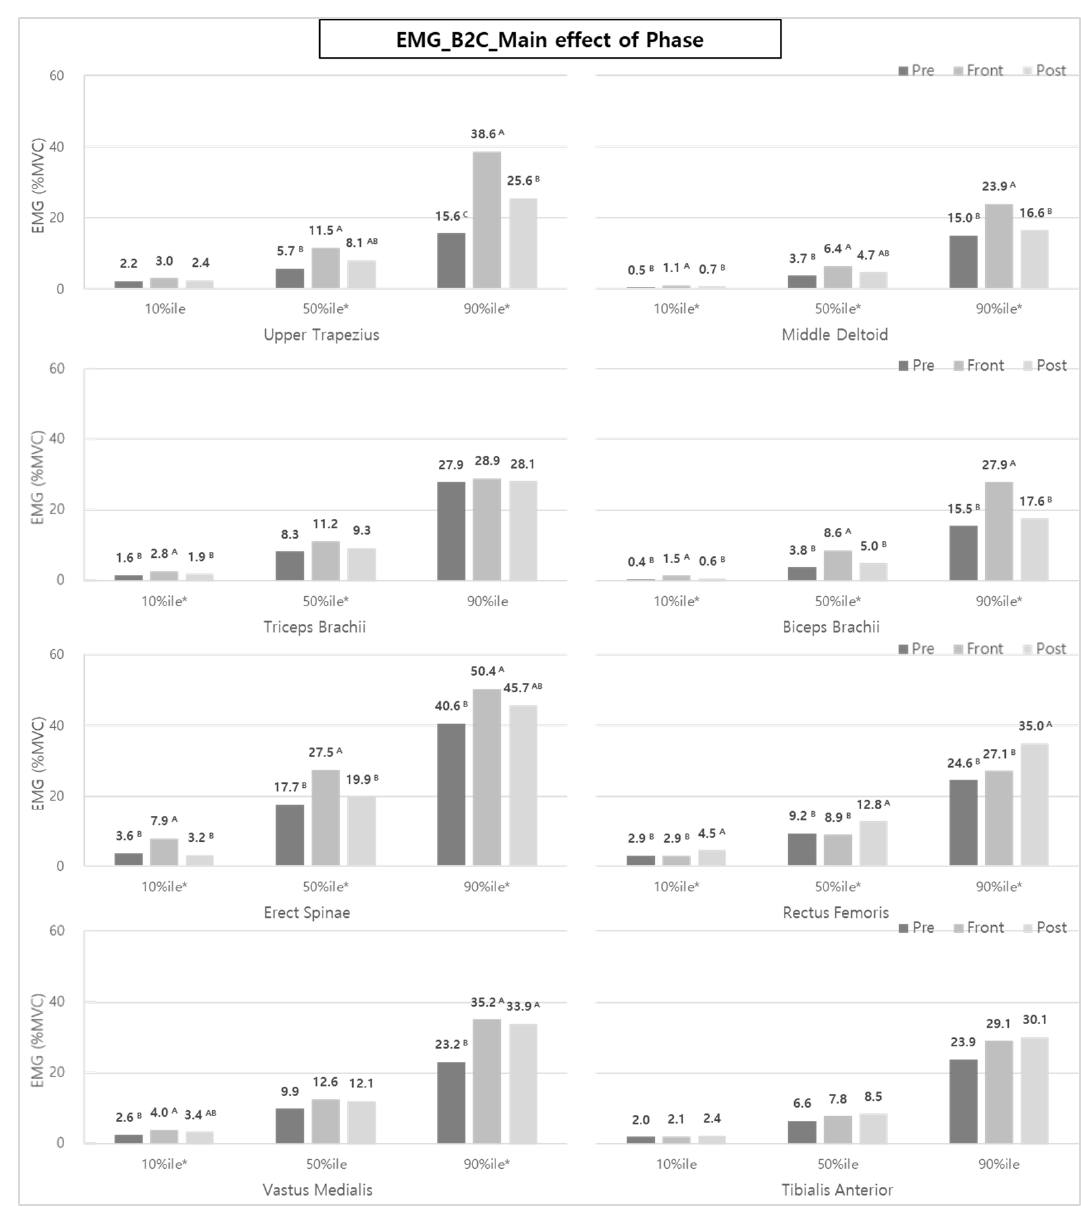
Figure 7. The effect of phases on each muscle activity during B2C. Asterisk (*) and the alphabet capital letter (A and B) indicate that the difference between means is statistically significant at p < 0.05. The muscles of the upper and lower limbs (UT, MD, RF, and VM) and back (ES)